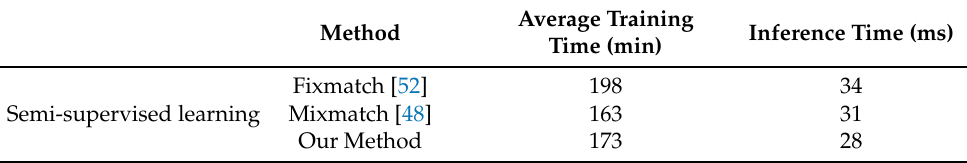
Table 6. The comparison results of calculation time on the UCM